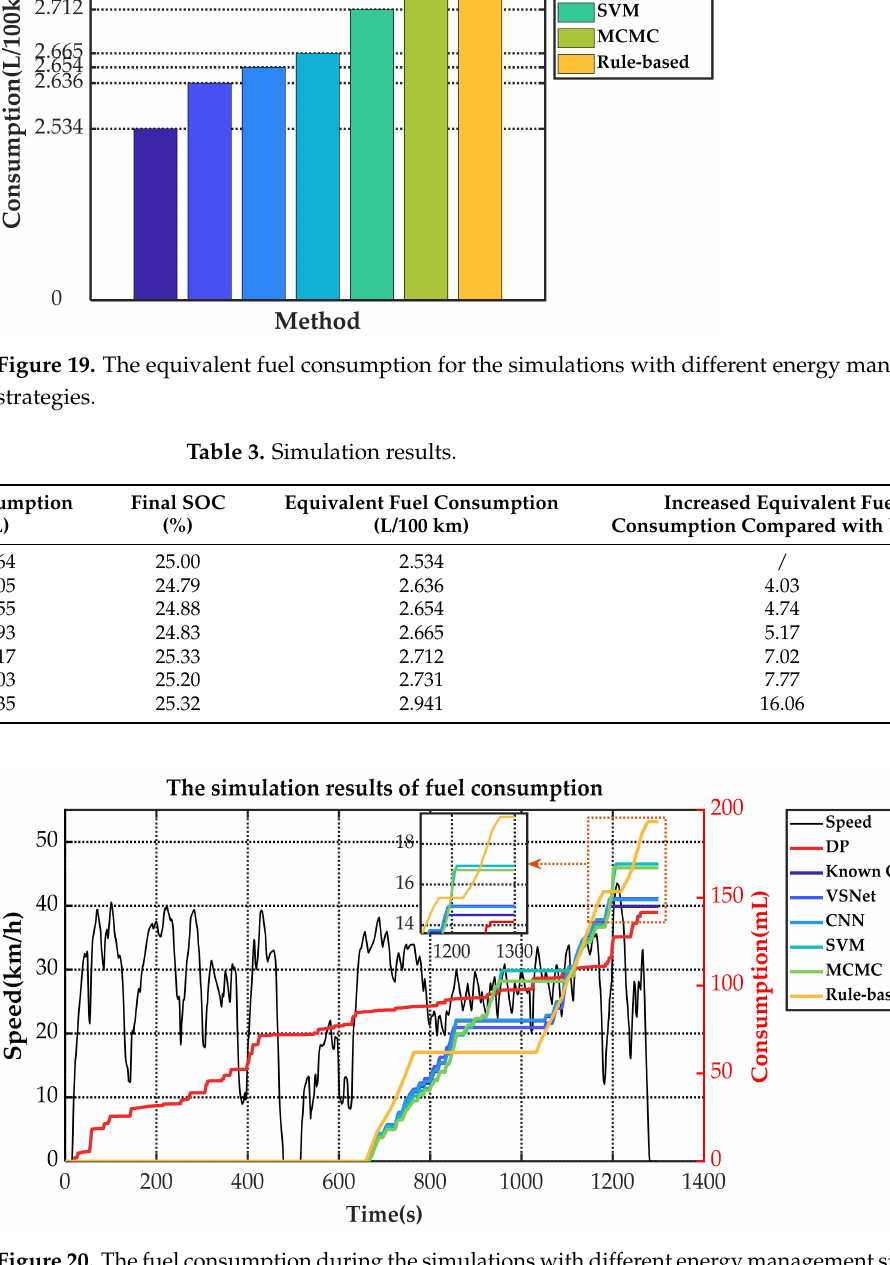
Figure 20. The fuel consumption during the simulations with different energy management